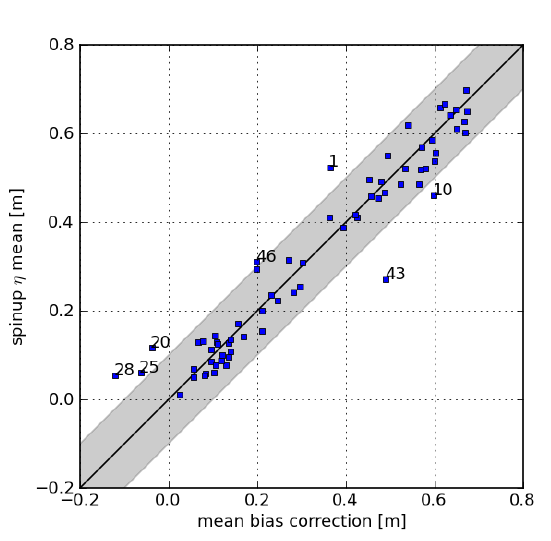
Figure 10. Magnitude of the temporal mean of bias correction matched against model MDT surface at each location. An arbitrary mismatch threshold of 10 cm is used to highlight apparent